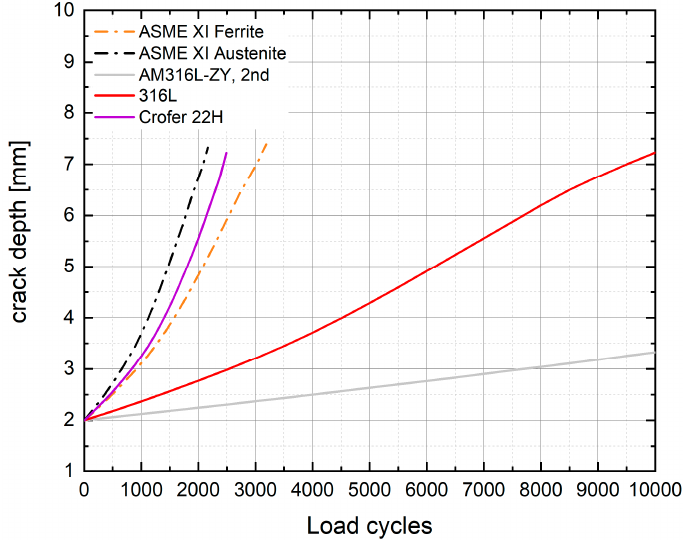
Figure 27. Calculated growth of a postulated 2 mm deep and 40 mm wide surface crack under cyclic loading (f = 20 Hz, R = 0.1) in various materials (ASME curves for comparison) at ambient temperature.